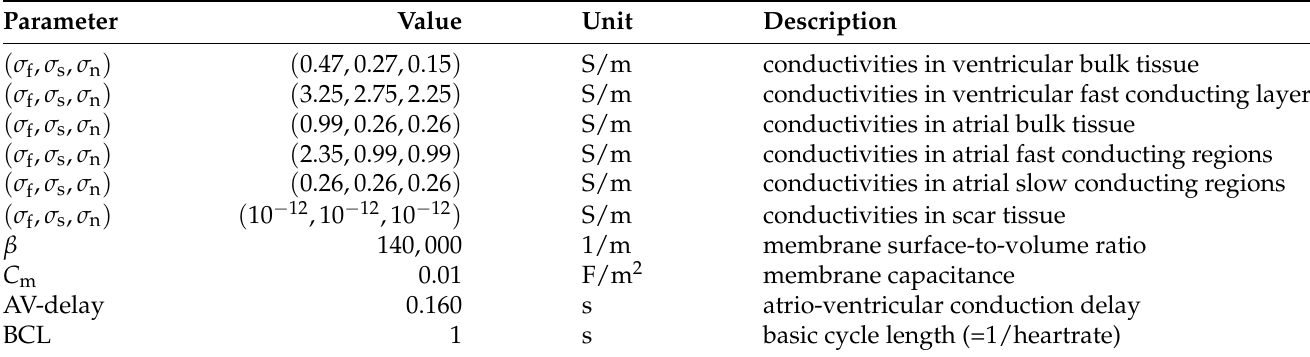
Table 1. Overview of electrophysiological parameters for the whole heart model.